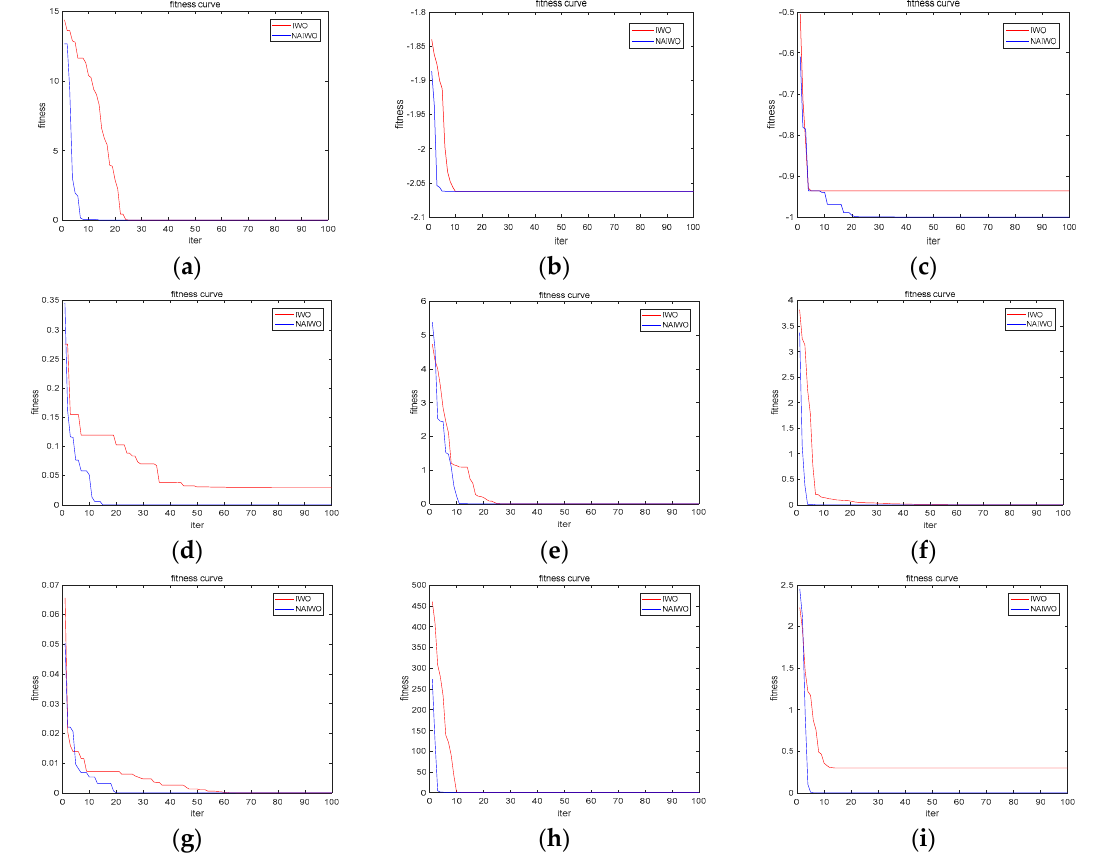
Figure A2. Comparison of the fitness curves between NAIWO and IWO. The maximum number of iterations selected in the test is 300. In order to better display the contrast, the first 100 generations are selected when generating the image. ( a ) Ackley function (F1), ( b ) Cross-in-Tray function (F2), ( c ) Drop-wave function (F3), ( d ) Griewank function (F4), ( e ) Levy function (F5), ( f ) Rosenbrock function (F6), ( g ) Scha ff er function (F7), ( h ) Schwefel function (F8), and ( i ) Three-hump camel function